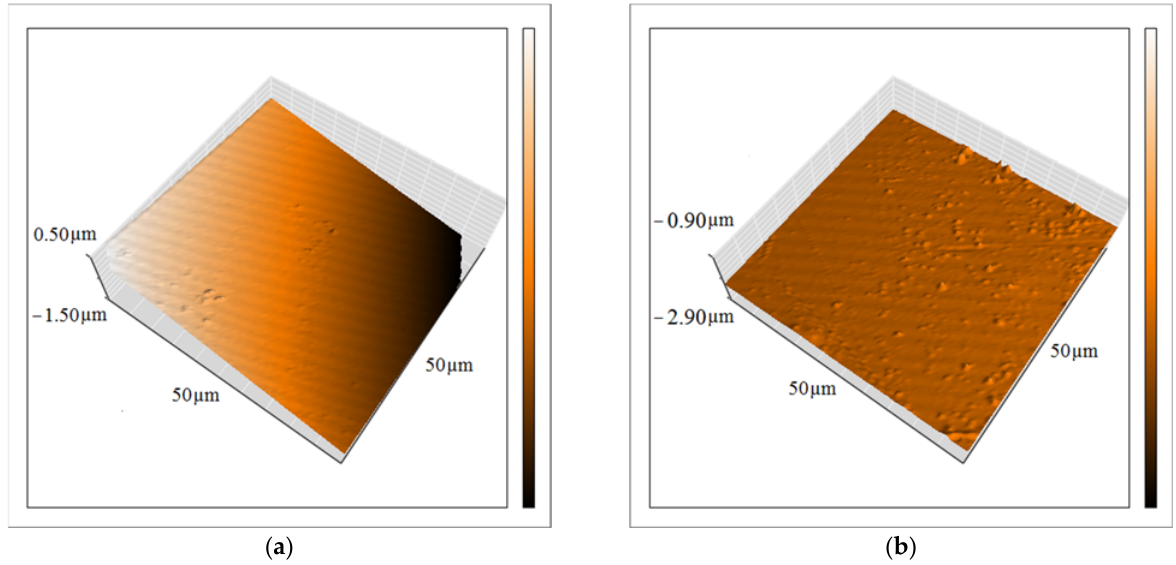
Figure 9. Topography of the neat ( a ) and ZHS ‐ containing ( b ) epoxy coatings obtained by the AFM.